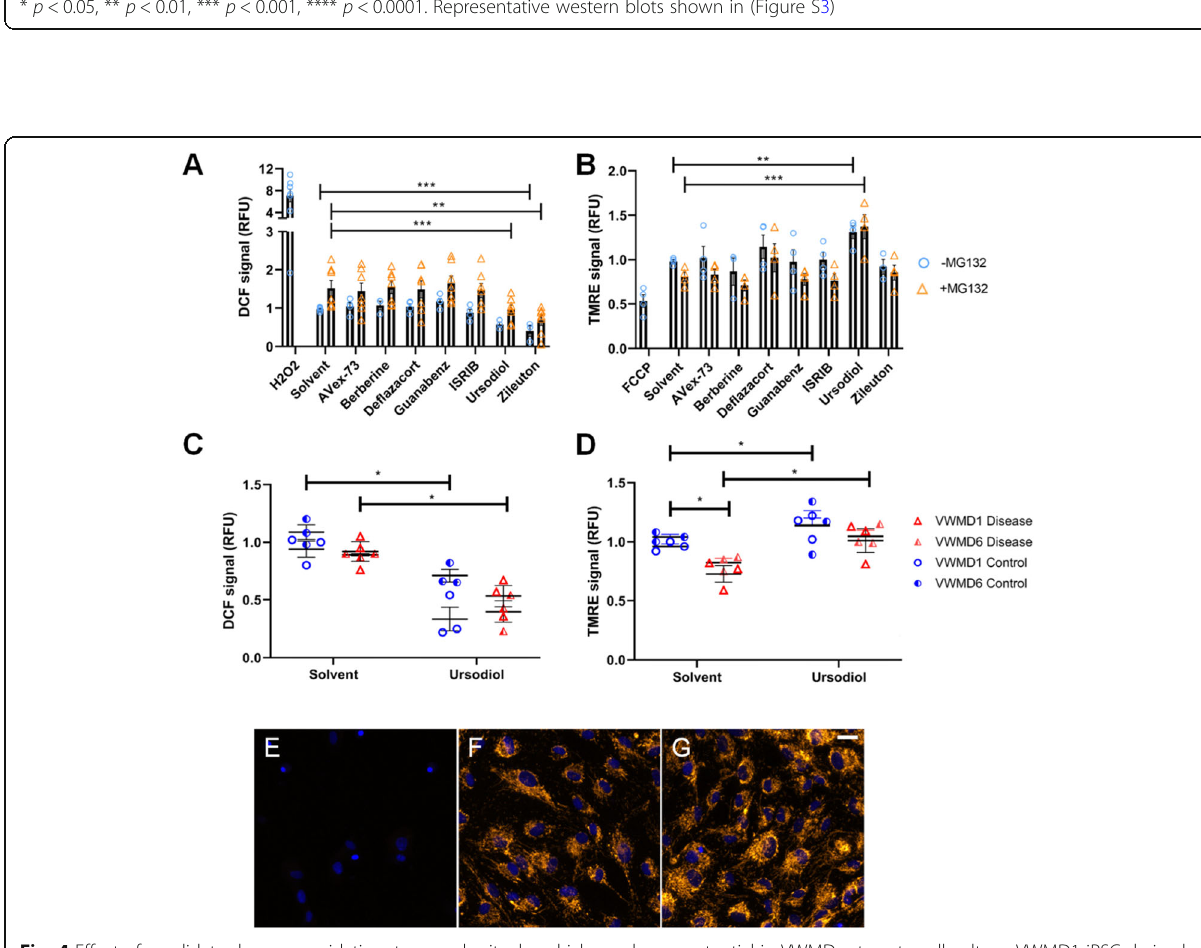
Fig. 4 Effect of candidate drugs on oxidative stress and mitochondrial membrane potential in VWMD astrocyte cell culture. VWMD1 iPSC-derived astrocytes were treated with vehicle control (DMSO; blue circle) or 0.1 μ M MG132 (orange triangle) and candidate drugs for 24 h. ( a ) Reactive oxygen species measured via DCF fluorescence and ( b ) TMRE fluorescence as an indicator of mitochondrial membrane potential. Effect of ursodiol on ( c ) ROS generation via DCF fluorescence and ( d ) mitochondrial membrane potential via TMRE fluorescence in disease and control astrocyte cultures. Representative confocal fluorescence microscopy images of: ( e ) FCCP (protonophore, mitochondrial uncoupler, loss of TMRE fluorescence), ( f ) TMRE assay solvent, ( g ) ursodiol in VWMD1 EIF2B5 R113H/A403V astrocytes (scale bar = 30 μ m) (orange = TMRE; blue = Hoechst 33342 nuclear stain). For A-D individual data points represent mean ± SEM (n = 3 – 6); significant differences were identified by two-way ANOVA followed by Holm-Sidak posthoc test * p < 0.05, ** p < 0.01, *** p <